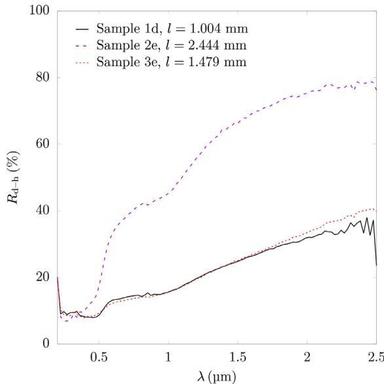
Directional–hemispherical reflectance for optically-thick samples of materials 1–3.